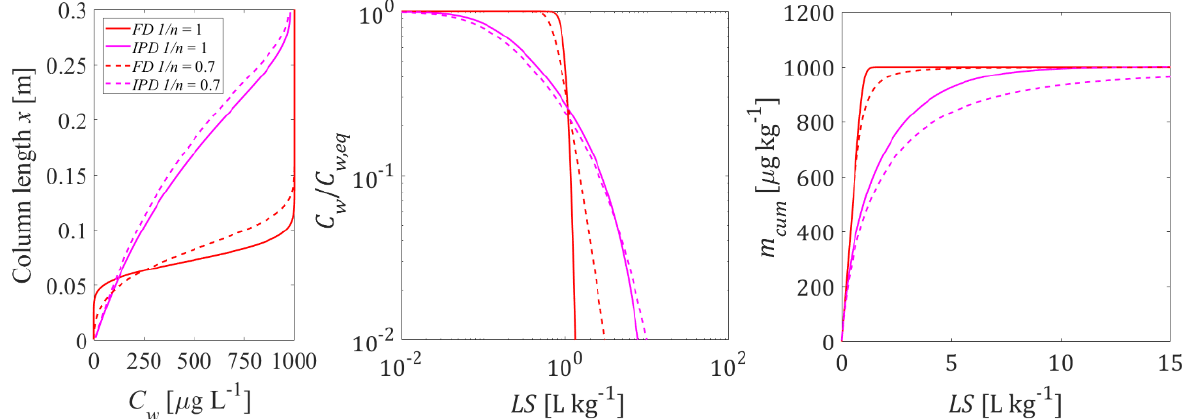
Figure 8. Influence of sorption non-linearity: initial aqueous concentration distribution in the column after the first flooding ( left graph ) and column effluent concentration (normalized: mid graph , cumulative: right graph ) vs. time (expressed as liquid to solid ratio: LS ); solid lines: linear sorption ( K d = 1 L kg − 1 ); dashed lines: non-linear sorption case (Freundlich coefficient K fr = 7.94, exponent 1/ n = 0.7); n = 0.45, v = 1.67 × 10 − 5 m s − 1 , α / x = 0 or 0.1, C s , ini = 1000 µ g kg − 1 , t c = 5 h, D aq = 1 × 10 − 9 m 2 s − 1 , ε = 0.05, d p , coarse = 2000 µ m.